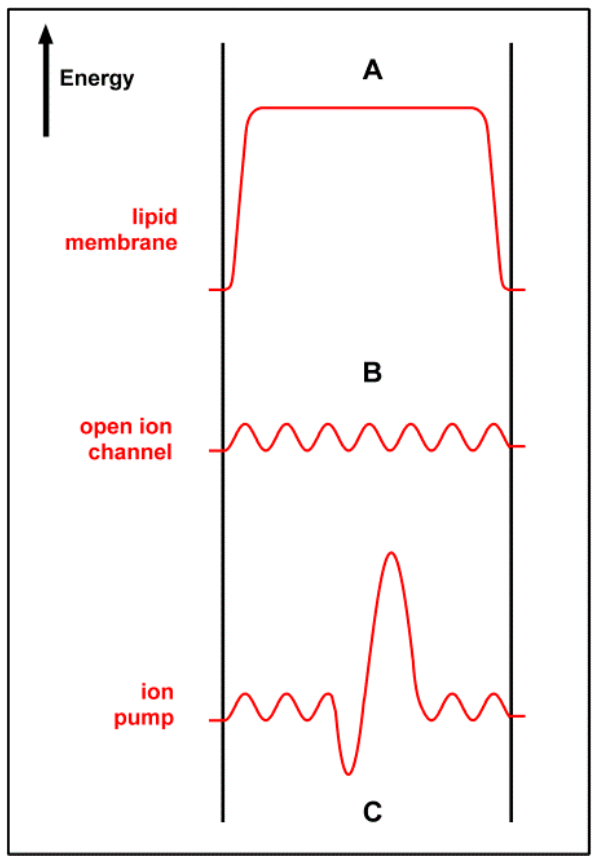
Figure 3. Schematic representation of potential energy profiles as detected by an ion along a pathway across a membrane in three dif- ferent cases: (A) a simple lipid membrane, in which specific effects of the membrane-water interface are neglected, (B) an ideal ion channel without binding sites, and (C) an ion pump with an inter- nal ion-binding site accessible from the left side and an energy bar- rier preventing propagation to the right-hand aqueous